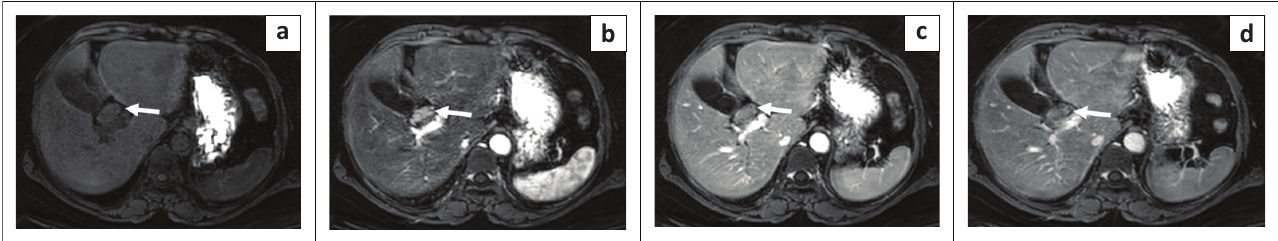
FIGURE 3: Dynamic post-contrast axial sequences revealing iso-intensity of the tumour (white arrow) on noncontrast (a), hyperenhancement on the late arterial phase (b), reduced hyperintensity on the porto-venous (c) and delayed (d) phases.